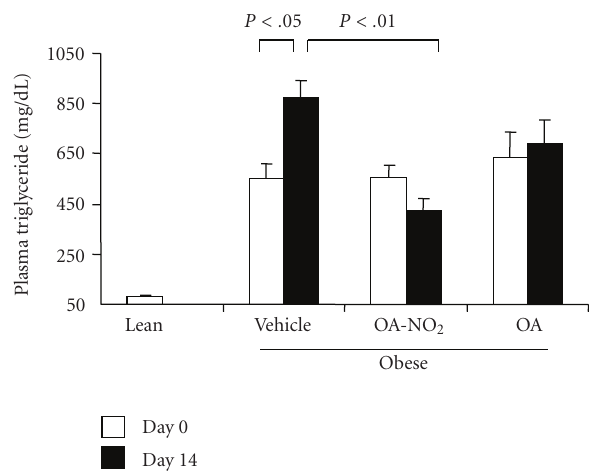
Figure 3: Plasma triglyceride in obese Zucker rats before and after 14-d infusion with vehicle, OA-NO 2 , or OA. Lean rats with vehicle treatment were used as controls. Lean: n = 3; Vehicle: n = 7; OA- NO 2 : n = 5; OA: n = 5. Data are mean ± SE.